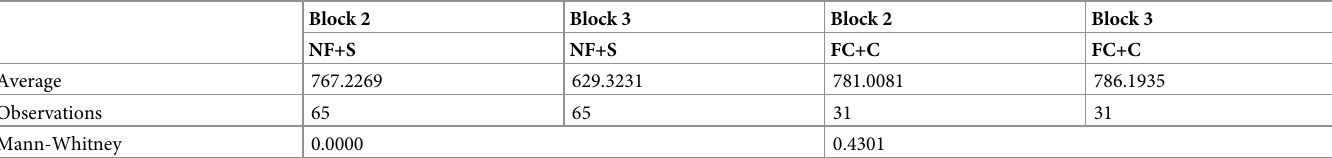
Table 4. Differences in contributions between second and third blocks.